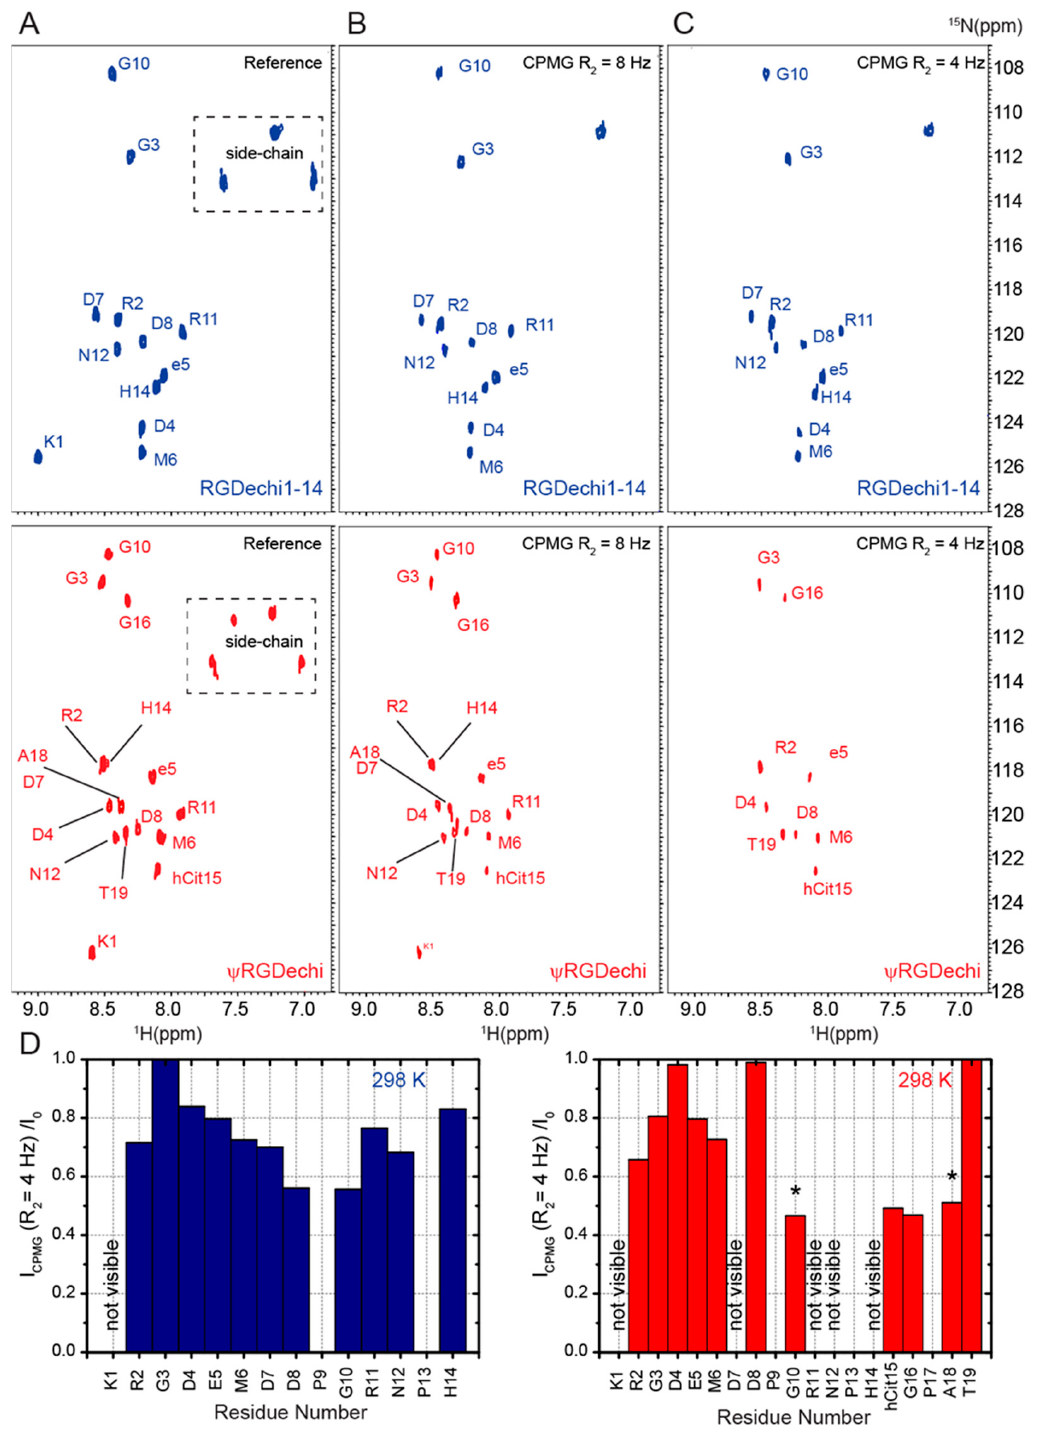
Figure 6. Microsecond to millisecond backbone motions of RGDechi1-14 and ψ RGDechi. ( A – C ) Comparison of the reference 1H-15N HSQC experiments recorded for RGDechi1-14 and ψ RGDechi with the filtered 1H-15N HSQC spectra of both peptides acquired using a relaxation-compensated CPMG period of 125 ms (R 2 = 8 Hz) ( B ) and 250 ms (R 2 = 4 Hz) ( C , D ) Normalized intensity ratios between the NMR signal observed for RGDechi1-14 (left) and ψ RGDechi (right) at 298 K in the T 2 - filter 1H-15N HSQC experiments (CPMG R 2 = 8 Hz) (I CPMG ) with the values observed in the 1H-15N HSQC spectra acquired without any filter (I 0 ). The asterisk indicates the residues exhibiting low signal to noise